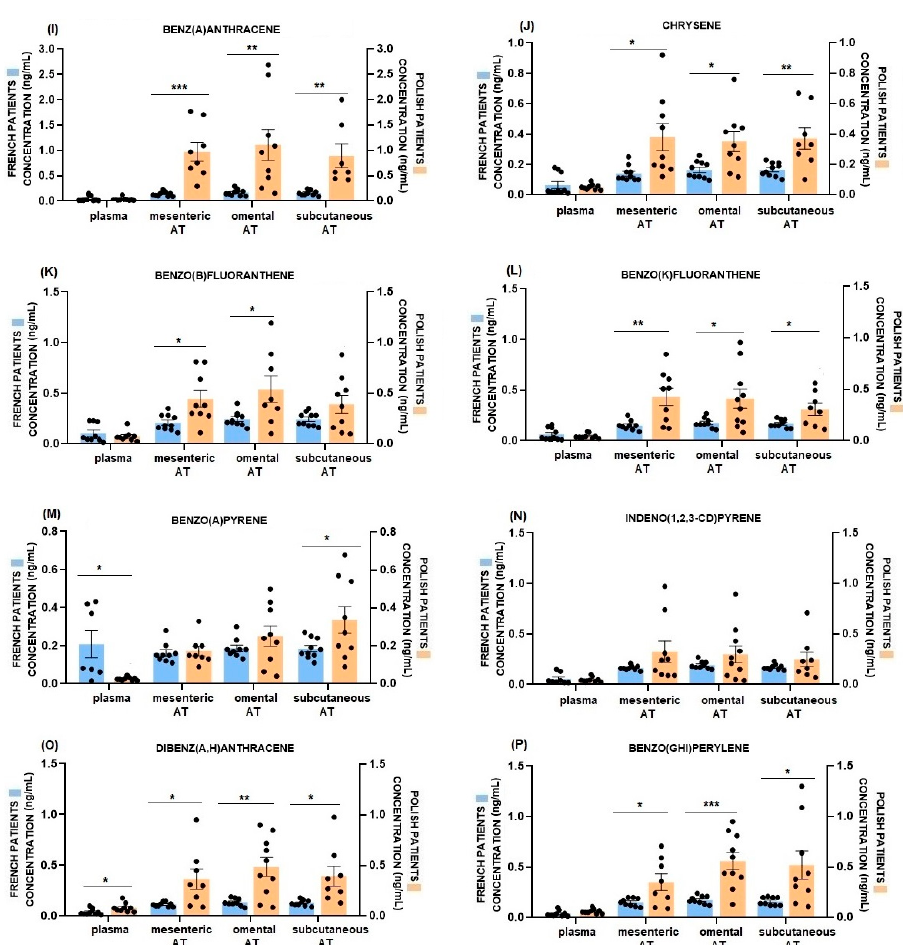
Figure 1. Comparison of PAH concentration in blood plasma and three types of AT between French (blue bar chart) and Polish patients (orange bar chart) ( A – P ) panel. Data are given as mean ± SEM, * p ≤ 0.05; ** p ≤ 0.01; *** p ≤ 0.001 and **** p ≤ 0.0001.